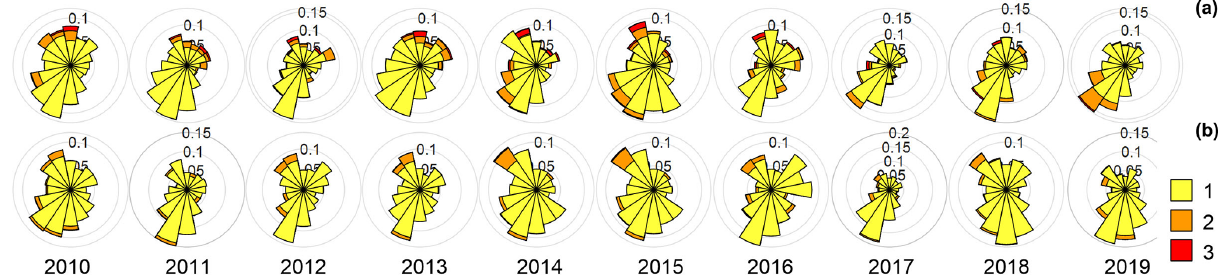
Figure 6. Annual wind rose for 2010–2019 at 10m (a) and 2m (b) . Legend for wind speed: 1: 0.5–2ms − 1 ; 2: 2–5ms − 1 ; 3: > 5ms − 1 . Wind direction for wind speed below 0.5ms − 1 was not accounted for in